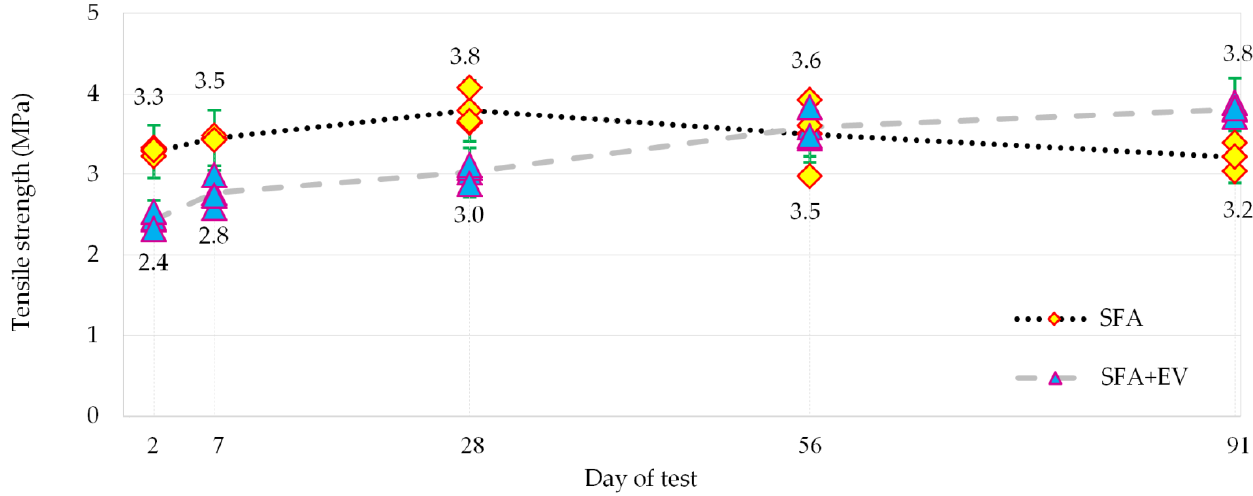
Figure 9. Tensile strength.